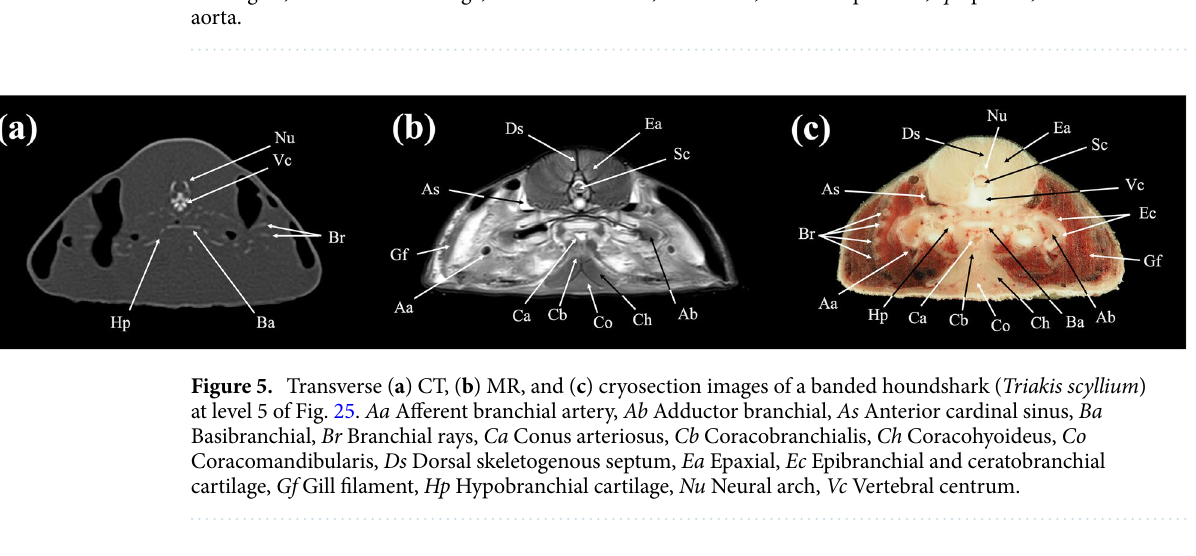
Figure 4. Transverse ( a ) CT, ( b ) MR, and ( c ) cryosection images of a banded houndshark ( Triakis scyllium ) at level 4 of Fig. 25. Al Ampullae of Lorenzini, Am Adductor mandibularis, Cc Ceratohyal cartilage, Ch Coracohyoideus, Co Coracomandibularis, Hc Horizontal semicircular canal, Hs Hyoidean sinus, Me Medulla Oblongata, Mc Meckel’s cartilage, Ne Neurocranium, Ot Otolith, Pa Palatoquadrate, Sp Spiracle, Va Ventral aorta.